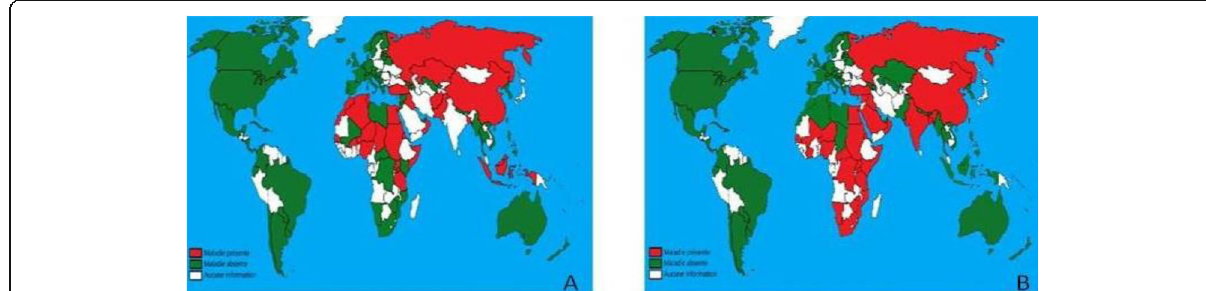
Fig. 1 A Sheep pox geographic distribution. B Lumpy skin disease geographic distribution. Source: (Hamdi et al. 2021). The red color indicates the presence of